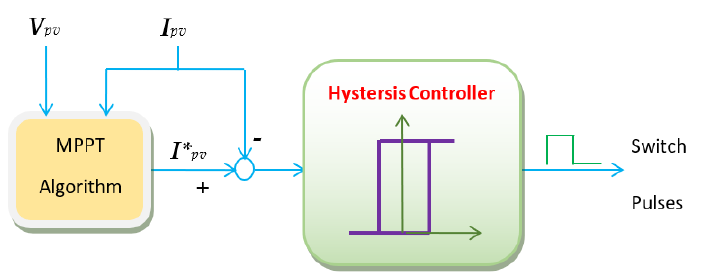
Figure 3. MPPT controller block diagram.